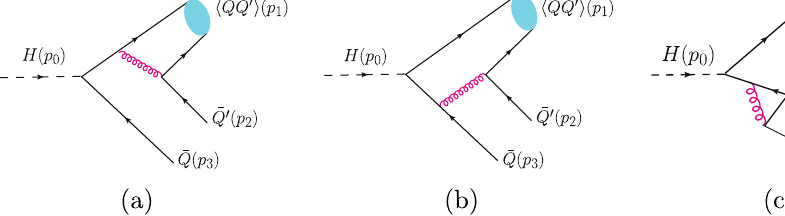
Fig. 1 Feynman diagrams for the process H ( p 0 ) → (cid:3) QQ (cid:4) (cid:5)[ n ] ( p 1 ) + ¯ Q (cid:4) ( p ) + ¯ Q ( p ) ,where Q and Q (cid:4) denoteastheheavy c or b quark, [ n ] is 2 3 the spin and color quantum number of the diquark state, i.e., (cid:3) cc (cid:5)[ 1 P 1 ] ¯